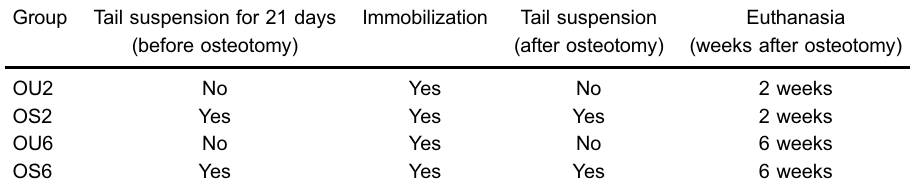
Table 1. Experimental design.